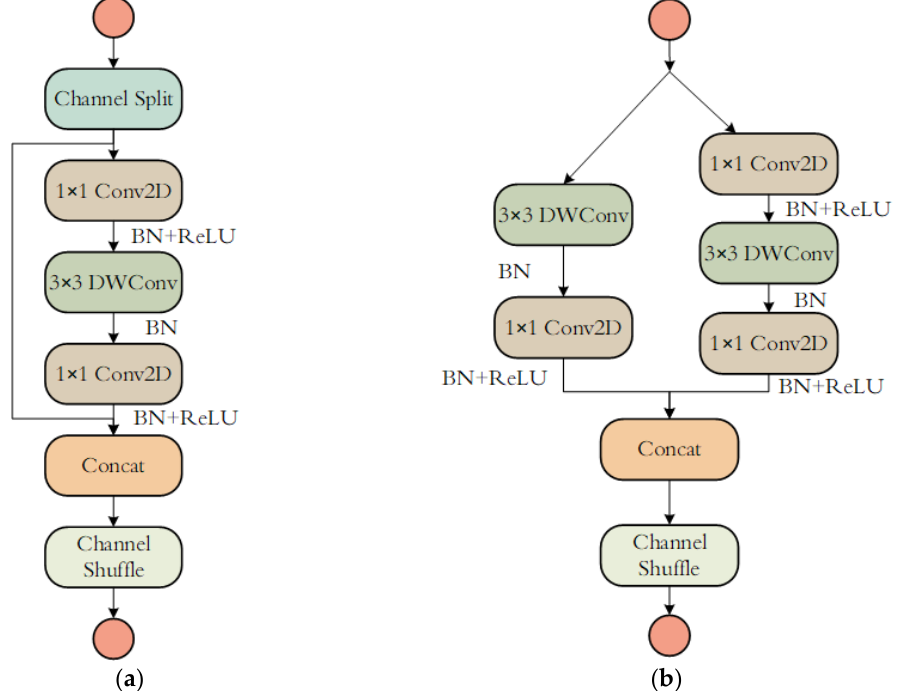
Figure 4. The structure of ShuffleNet-V2 Units: ( a ) the structure of ShuffleNet-V2 Unit1; ( b ) the structure of ShuffleNet- V2 Unit2.